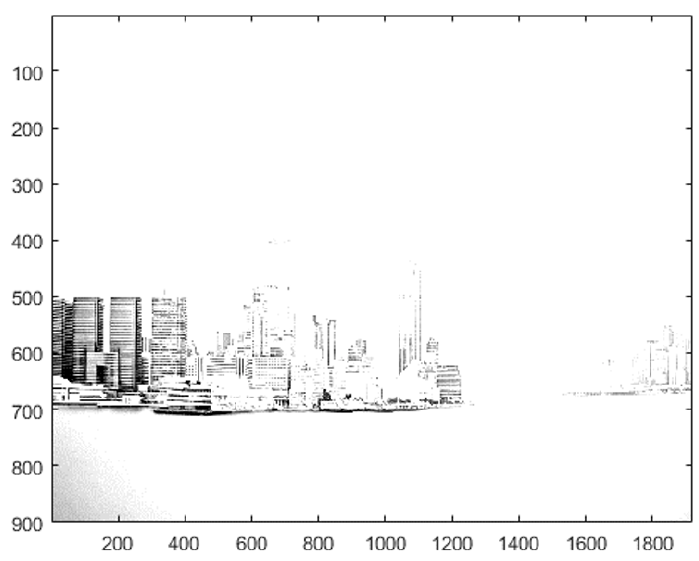
Figure 5. Image with grayscale 50–100.